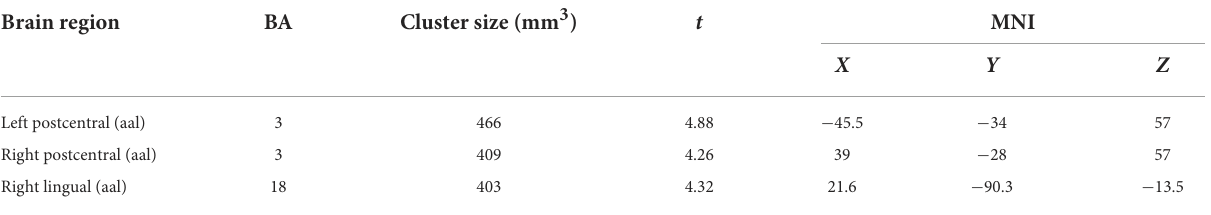
TABLE 2 VBM analysis of significant GM cluster in HA vs. CG.